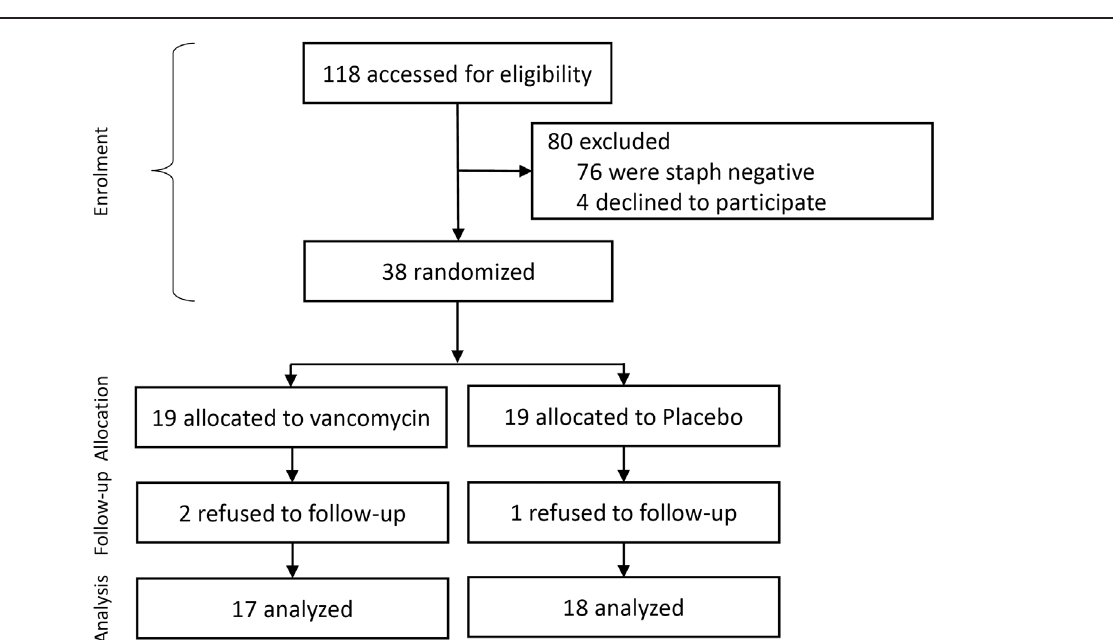
Flowchart of progress through the trial.